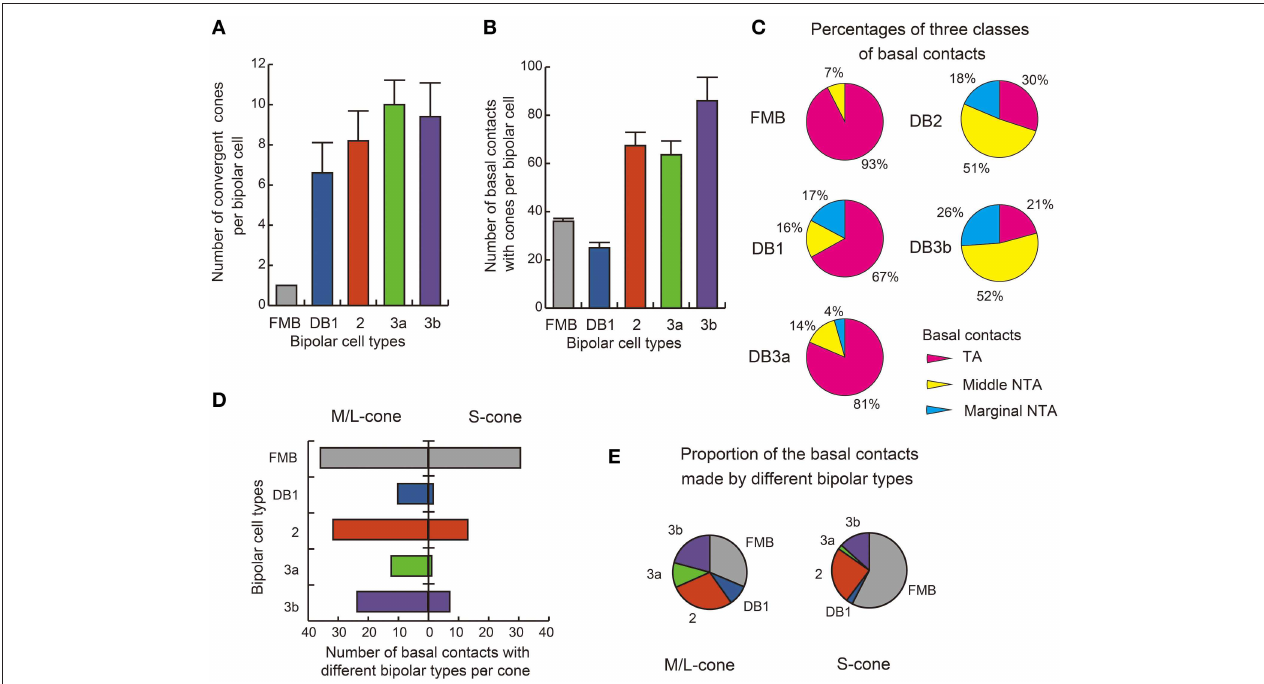
FIGURE 6 | Summary of basal synapse counts. (A) The number of cones converging onto each bipolar cell (every cone was equally counted as unity regardless of the number of synaptic contacts). (B) The total number of contacts of the three positional classes between bipolar dendrites and cone pedicles. The data are averaged for each OFF bipolar cell type ( n = 5 ) with SD (A,B) . (C) Pie charts showing the average proportions of the three positional classes of basal synapses. All FMB cells ( n = 5 ) are of the M/L cone-connected type. (D) Comparison of S cone (right-handed bars, n = 2 ) and M/L cone (left-handed bars, n = 4 ) divergence for the five types of bipolar cells. The abscissa is the average number of basal contacts of a cone with each type of bipolar cell. (E) Pie charts showing comparison of S-cones and M/L-cones in the innervation of different bipolar